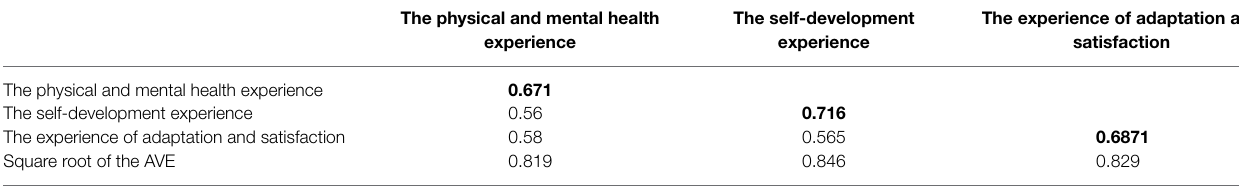
TABLE 5 | Correlation between SWB subscales.